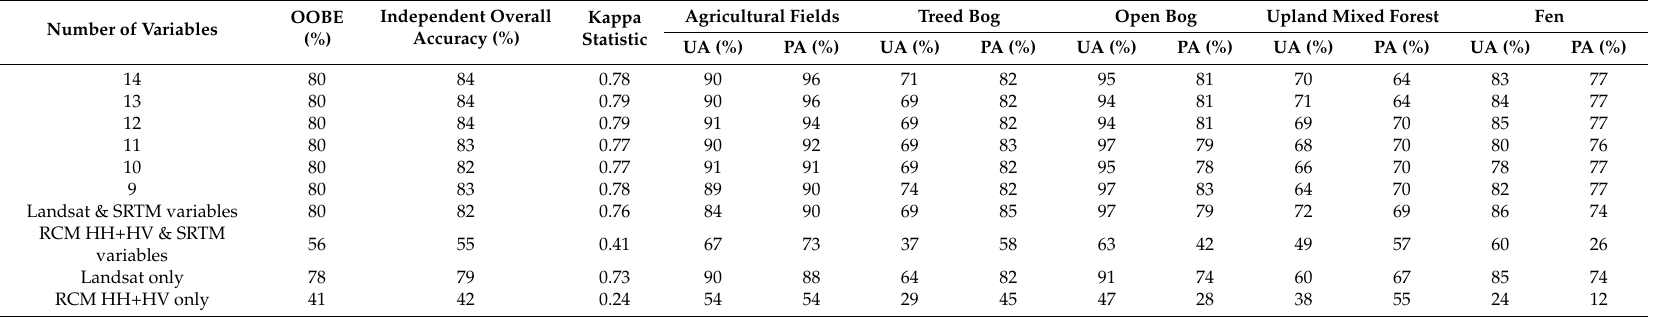
Table A5. Statistical results from the RCM Dual Pol HH+HV NESZ − 25 dB (2 May 2014), Landsat-8 (24 April 2014), and SRTM variables spring model. The first iteration was run with all 14 variables, and variables ranked to be unimportant were then removed until 9 variables remained. The final variables in the model with the highest independent overall accuracy (13 variables) in order of decreasing importance were the seven Landsat-8 bands, HH Intensity, HV Intensity, Total Power, HH/HV ratio, SRTM DEM, and SRTM